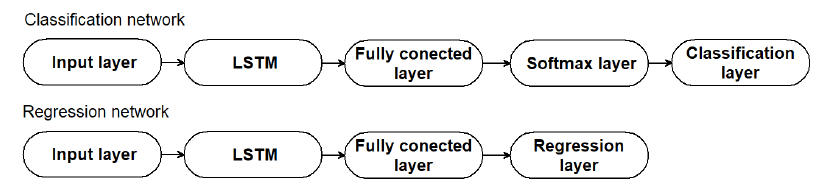
Figure 15. General architecture of LSTM neural networks.